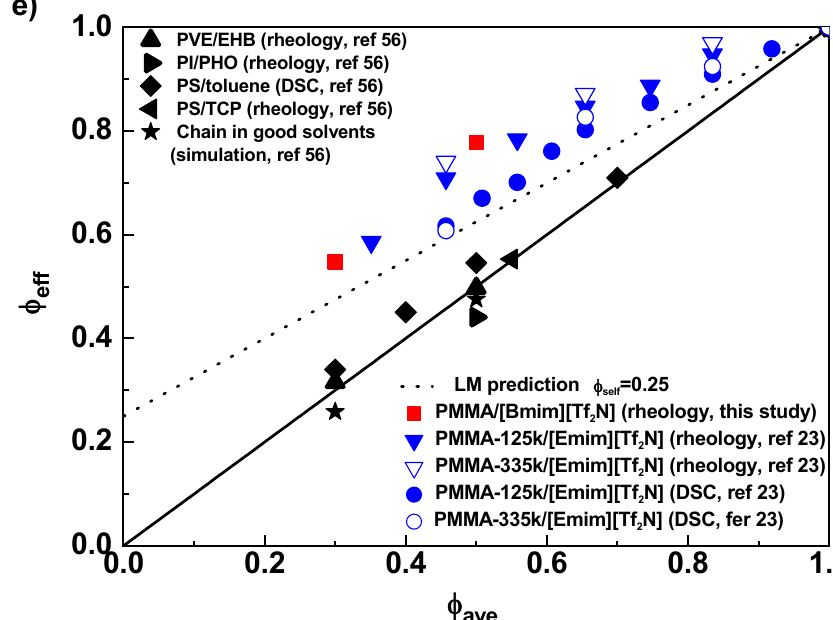
Figure 2. ( a ) The master curve, ( b ) the horizontal shift factor, and ( c ) the normalized terminal relaxation time τ d / ϕ 2.0 for PMMA and its solutions in [Bmim][Tf 2 N] at T ref = 150 °C. ( d ) The effective glass transition temperatures as function of volume fraction ϕ for PMMA/[Bmim][Tf 2 N] in this study ( ■ ) and PMMA/[Emim][Tf 2 N] in ref [23] ( ▼ , ▽ for rheology and ● , ○ for DSC, unit k in legend representing kg/mol). The solid and dotted curves are predictions of LM model with self ‐ concentration ϕ self = 0 and 0.25, respectively. ( e ) ϕ eff as a function of ϕ ave for PMMA in IL solutions. The solid line is the diagonal representing ϕ eff = ϕ ave (or ϕ self = 0), while he dotted curve is prediction of LM model with ϕ self = 0.25. Also plotted are data for PVE/EHB ( ▲ ), PI/PHO ( ● ), PS/toluene( ◆ ), PS/TCP( ), and simulated chain in good solvent ( ★ ), from ref [56].